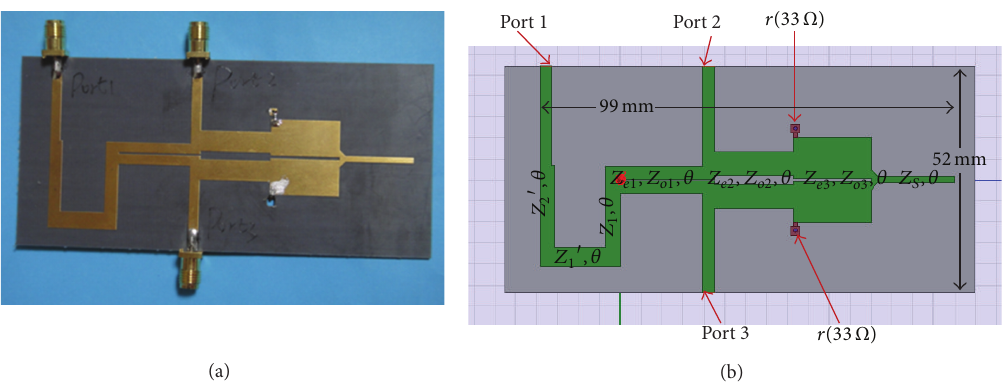
Figure 7: Fabricated coupled-line Gysel power divider operating at both 2 and 3.2 GHz. (a) Photograph and (b) 3D model.